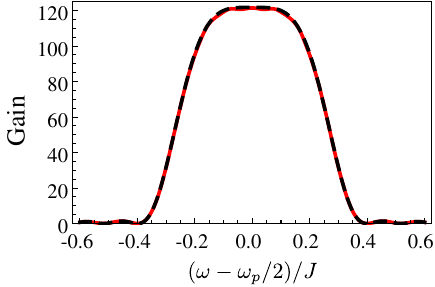
FIG. 6. Gain profile obtained in the effective 1D model with impedance-matched (black dashed line) and impedance- mismatched (red solid line) waveguides. Small (almost invisible) ripples appear in the gain for the impedance-mismatched case. Parameters are total length 80 sites, length of the amplification region 30 sites, ω 0 ¼ 2 . 14 J , Φ ¼ π = 2 , ν ¼ 0 . 08 J , κ ¼ 0 . 001 J , impedance mistmatch ϵ ¼ − 0 . 1